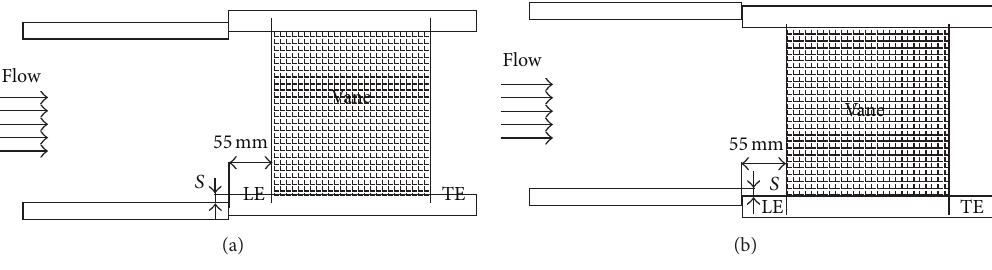
Figure 4: Stepped lower endwalls. (a) Forward-facing step. (b) Backward-facing